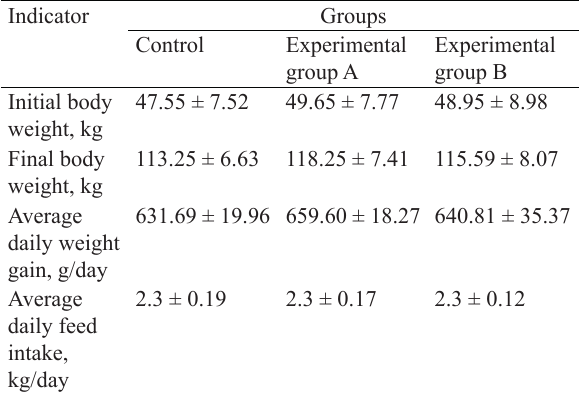
Table 4 Performance parameters of test pigs ( M ± m, n = 20)